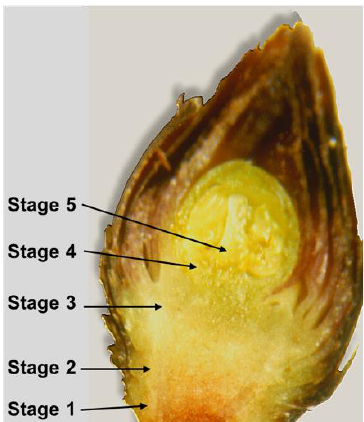
Figure 1. Stages of xylem vessel progression along the flower bud axis: 1 (at the base of axis); 2 (at 1 / 2 of axis); 3 (at 3 / 4 of axis); 4 (at the base of ovary); 5 (inside the pistil). Reproduced with permission from Andreini et al. [9], Trees, published by Springer Nature , 2012.